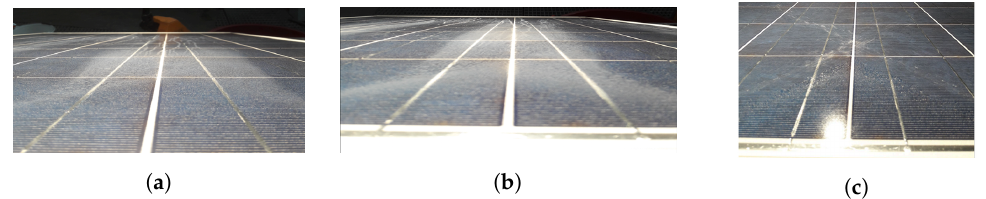
Figure 15. Water maldistribution on PV module with a spraying pressure of ( a ) 0.5 bar, ( b ) 1.0 bar and ( c ) 2.0